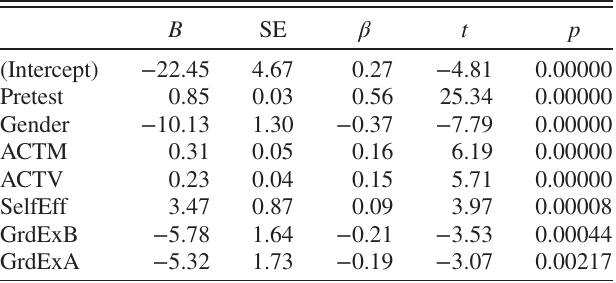
TABLE VIII. Post-test model with pretest and ACT and SAT scores. B is the regression coefficient, SE the standard error, β the standardized regression coefficient, t the t statistic, and p the probability a value as large or larger than t occurred by